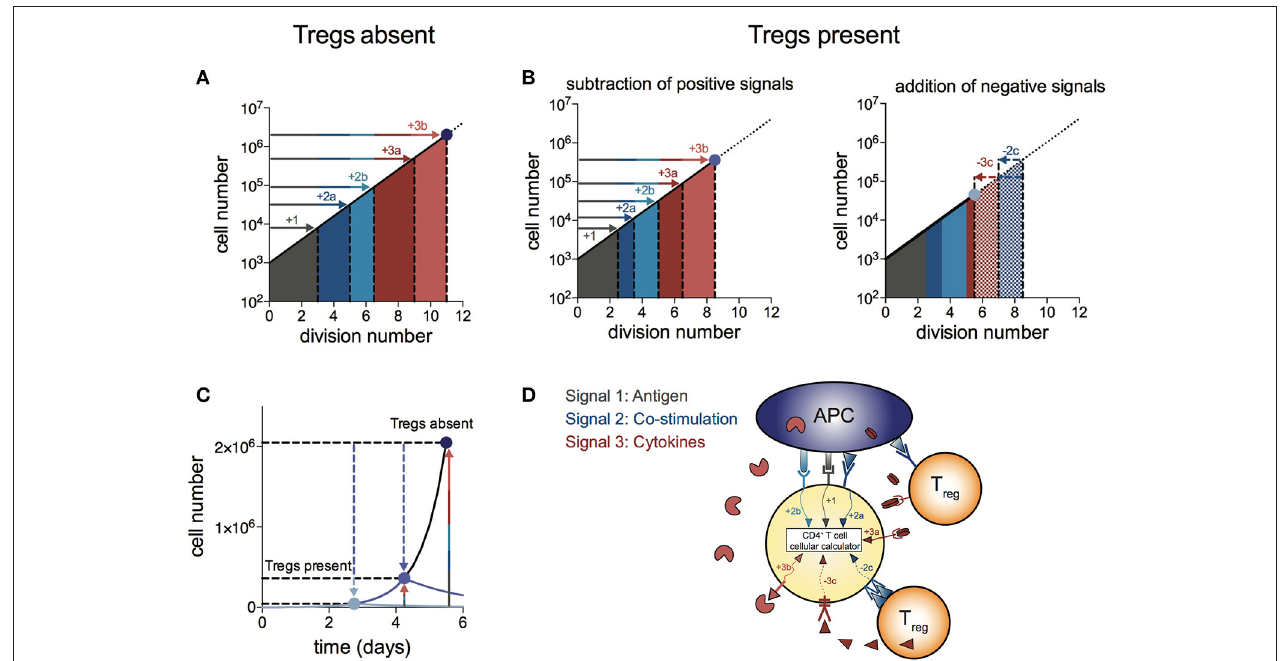
FIGURE 4 | Log-dampener model of suppression of CD4 + effector T cell proliferation by Tregs. (A) In the absence of Tregs, signals from antigen (signal 1—gray), co-stimulation (signal 2—blue) and cytokines (signal 3—red) sum linearly according to the number of divisions contributed to division destiny by each signal, resulting in an exponential increase in the magnitude of the T cell response (20) (note the log scale on the y-axis). “a” and “b” refer to different types of co-stimulatory and cytokine signals contributing positively to the T cell response. (B) Tregs regulate division destiny by reducing positive signals (1, 2a and 3a) and by adding negative signals (2c and 3c). (C) Illustration of the effect of Tregs on the size of the effector T cell response (note the linear y-axis). The blue dots represent the peak of the T cell response in the absence of Tregs (dark blue), after subtracting of positive signals (medium blue) and after addition of negative signals (light blue). (D) Schematic showing different types of signals being integrated within the CD4 + effector T cell according to the rules of the “cellular